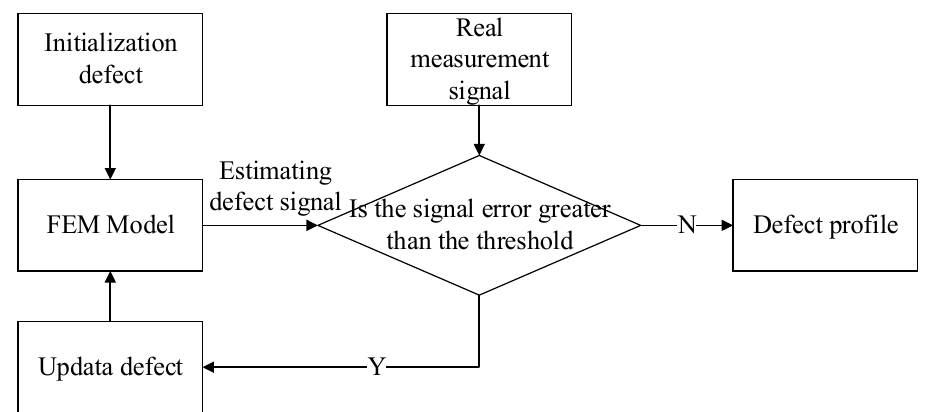
Figure 1. Iterative inversion process of magnetic flux leakage for pipeline defects.